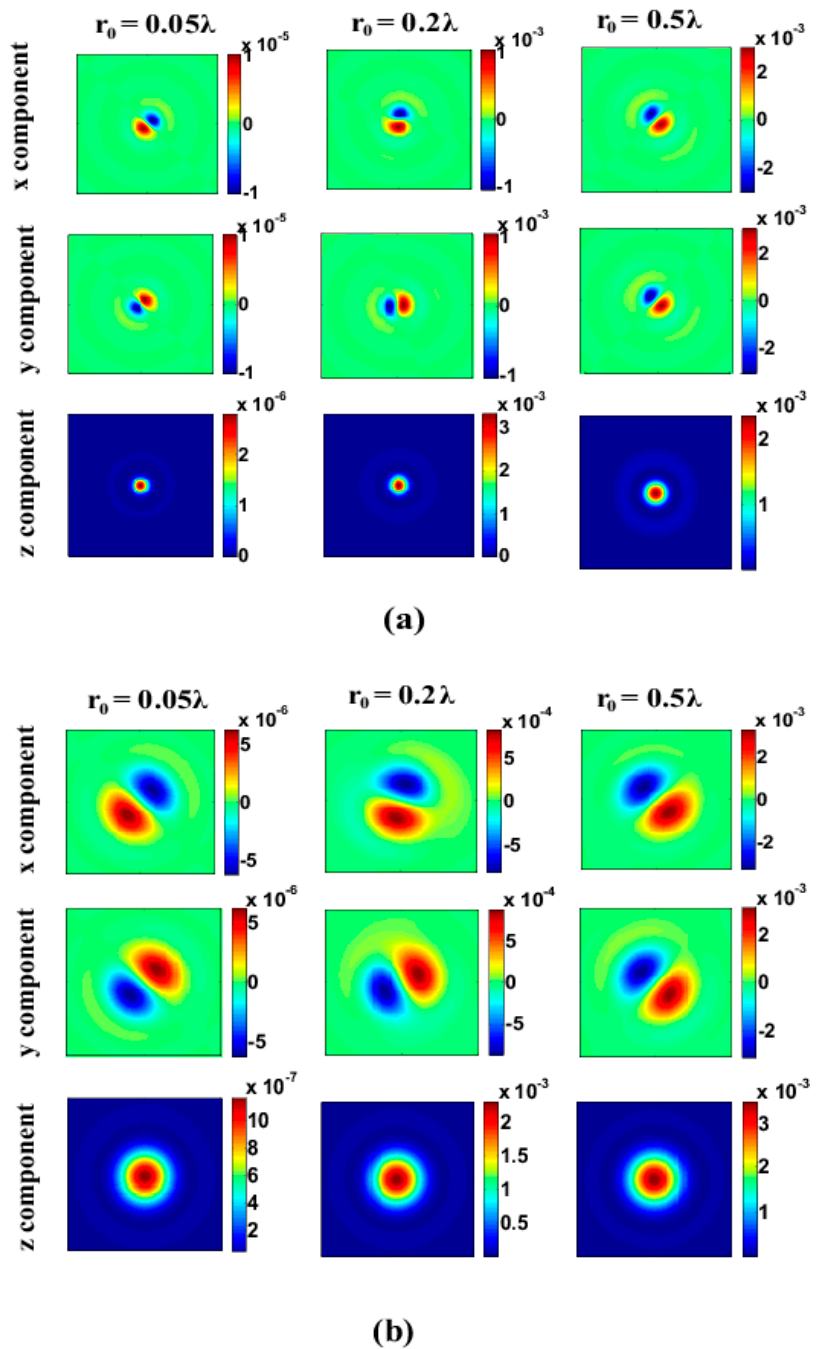
Figure 5. (Color online) The x , y , and z components of the SAM-FD of the evanescent wave and the propagating wave with w = 0.1 λ , z = 0.2 λ for different radial periods of initial SoP arrangement (i.e., different r 0 in this work): ( a ) the evanescent wave; ( b ) the propagating wave. Upper plots in ( a ) and ( b ) S x ; middle plots in ( a , b ) S y ; lower plots in ( a , b ) S z . All the images have the same dimension of 2 × 2 λ 2 .